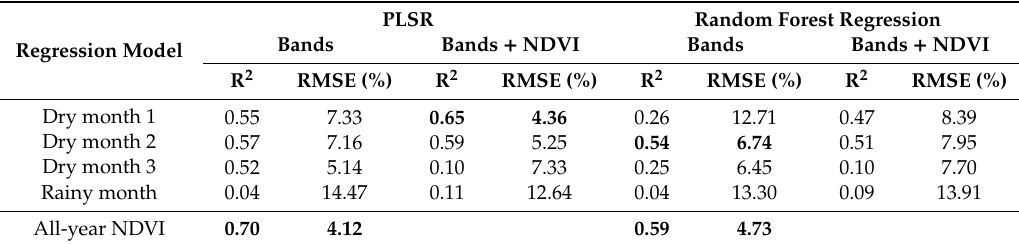
Table A5. R 2 and RMSE of the PLSR and Random Forest regression for the models combining Ethiopia and Tanzania (Scenario 3). The two best performing models for every method are marked in bold.